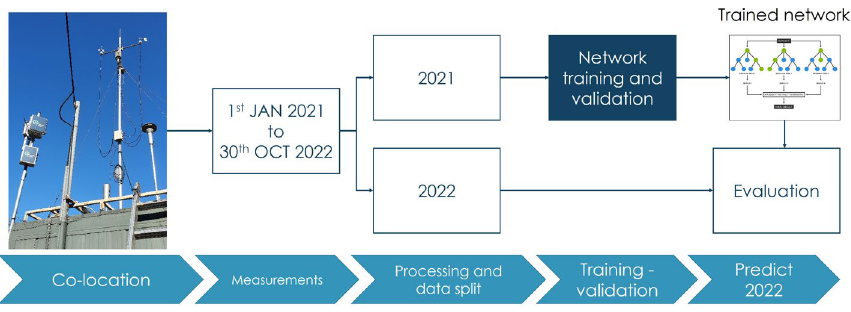
Figure 2. Training and evaluation/validation overview.